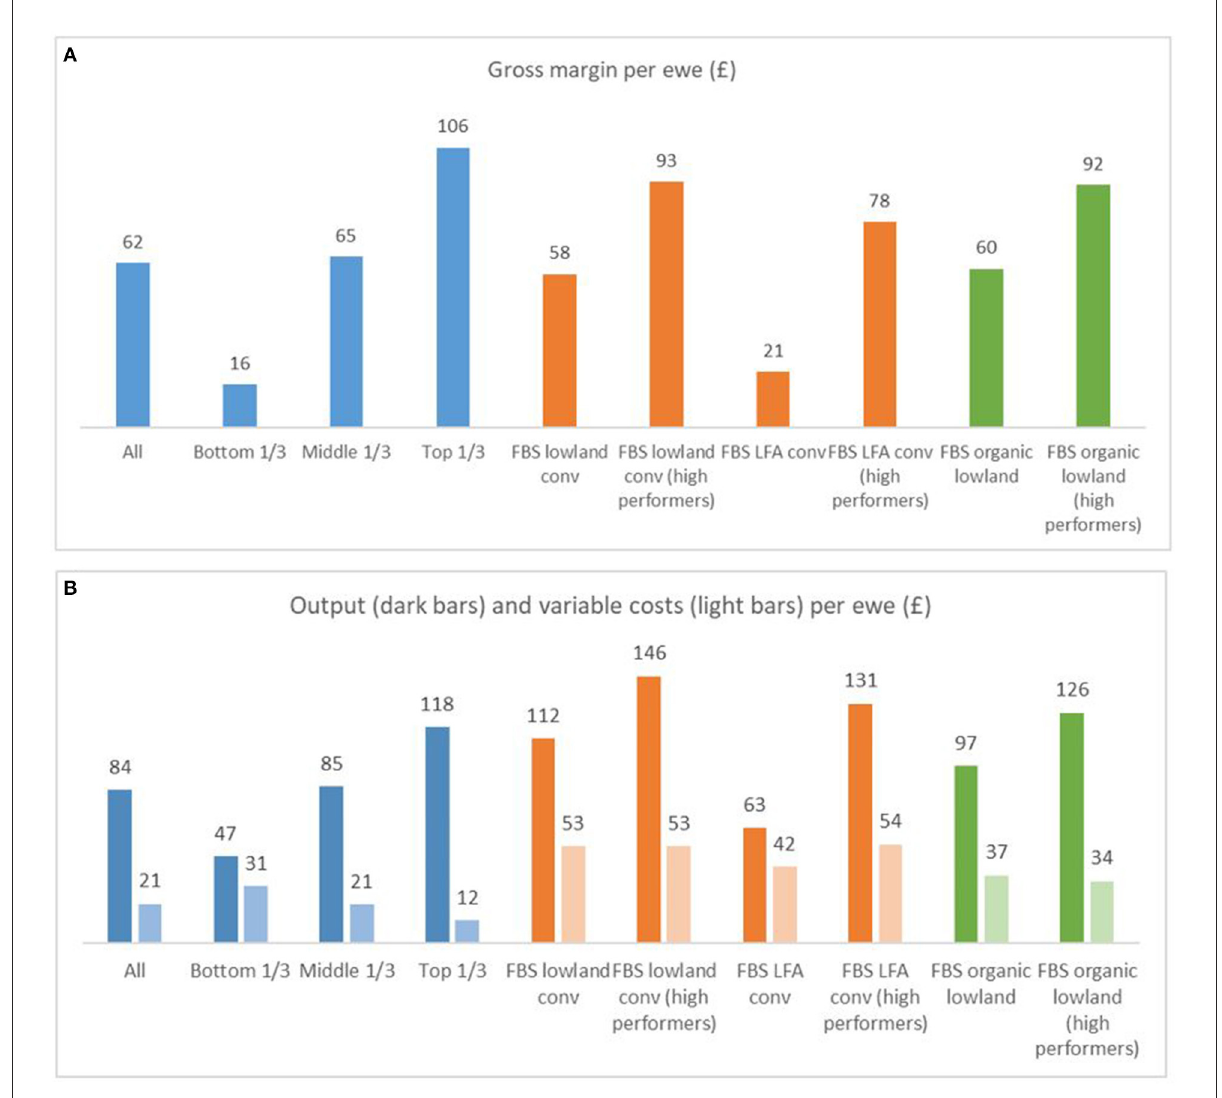
FIGURE3 Economic performance of PFLA sheep enterpr ises (blue) compared to Farm Business Survey data (orange) including organic (green) for the same year, (A) gross margins per ewe, (B) output and variable costs per ewe. All values are in £, specific values are given at the top of each bar.